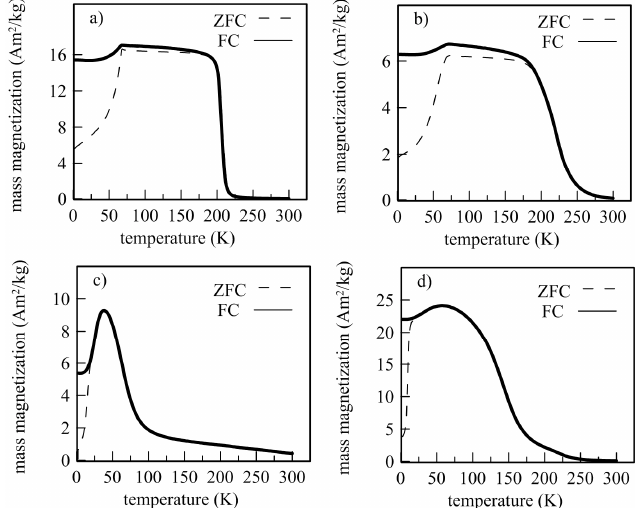
Figure 6. ZFC-FC curves of Fe 2 MnSi ( a , DS; b , RS) and Fe 2 MnAl ( c , DA; d , RA) alloys measured in magnetic field of 8 kA/m. Materials 2018 , 11 , x FOR PEER REVIEW Table 4. Magnetic parameters of Fe 2 MnSi (DS, RS) and Fe 2 MnAl (DA, RA) alloys determined from hysteresis loops (magnetization at 5 T, M 5; remnant magnetization, M r ; coercivity, H c ), by applying the Curie-Weiss law (Curie constant, C; Curie temperature, T C ), and from a maximum on zero-field-cooled (ZFC) curve (temperature of re-orientation, T R ).